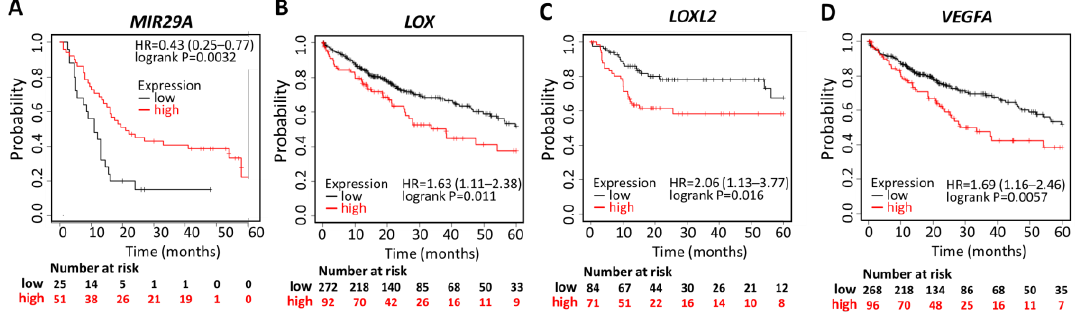
Figure 2. Prognostic value of MIR29A , LOX, LOXL2 , and VEGFA in HCC patients. Kaplan–Meier survival analysis representing the probability of the overall survival (OS) in HCC patients based on low vs. high expression of MIR29A ( A ), LOX ( B ), LOXL2 ( C ), and VEGFA ( D ). HR, hazard ratio.